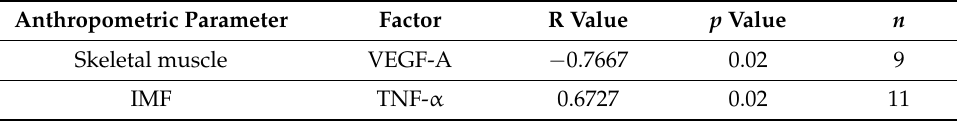
Table 3. Anthropometric parameters correlating with secreted factors from